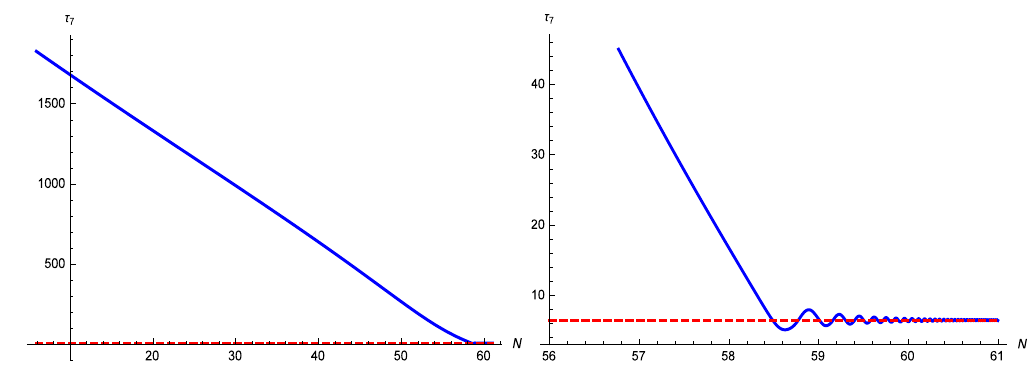
Figure 6 . Evolution of τ 7 as a function of the number of efoldings N for (left) the entire inflationary dynamics and (right) for the last 2 efoldings. The dashed red line represents the position of the final global